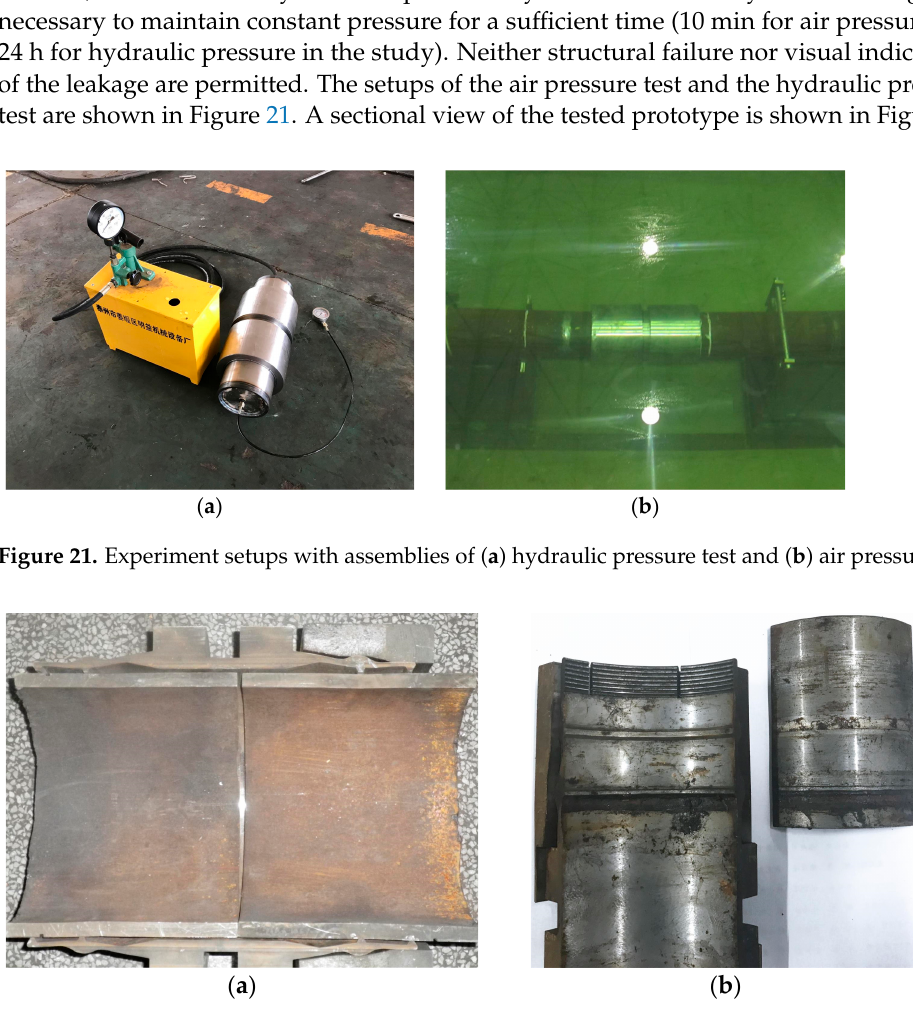
Figure 22. Section view of assemblies of ( a ) DN 200 and ( b ) DN 80.